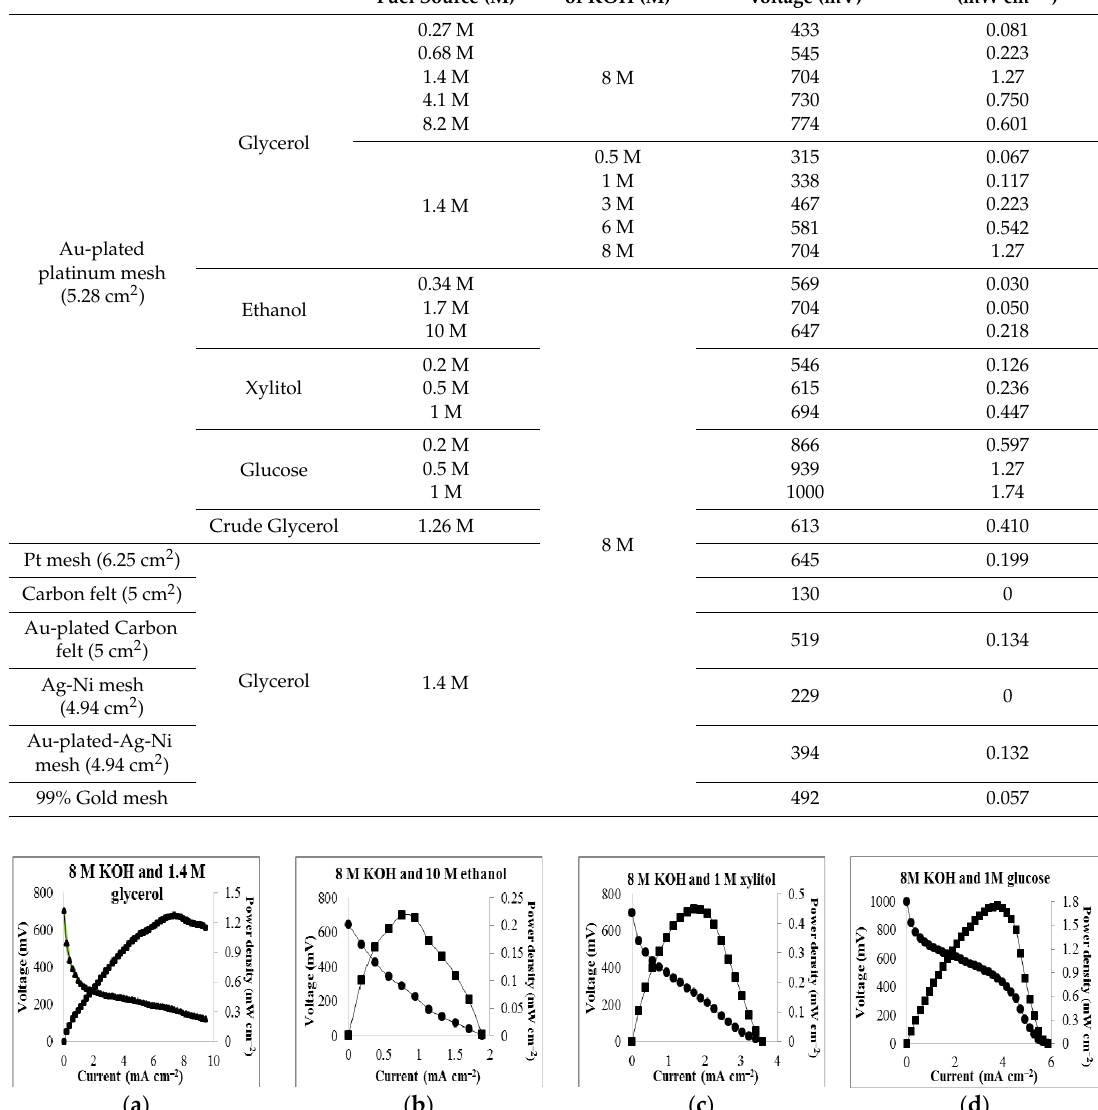
Figure 2. Polarization curve and power output for ( a ) 1.4 M glycerol in 8 M KOH solution; ( b ) 10 M ethanol in 8 M KOH solution; ( c ) 1 M xylitol in 8 M KOH solution; ( d ) 1 M glucose in 8 M KOH solution.